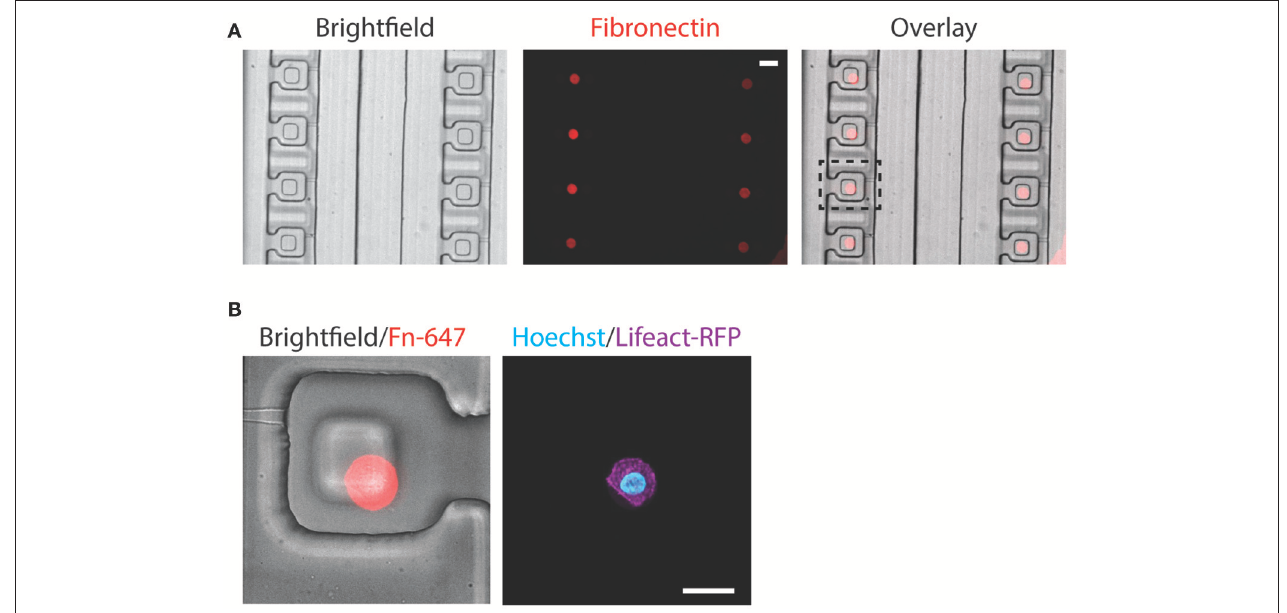
FIGURE 5 | Alignment of microcontact-printed fibronectin for the attachment and compression of cells. (A) Brightfield and fluorescence images of the device and fibronectin, respectively. Scale bar = 50 µ m. (B) Zoomed-in brightfield and fluorescence image of the device and fibronectin, respectively (left). Fluorescence image of the MCF-10A cell, labeling the DNA (cyan) and actin (magenta) (right). Scale bar = 20 µ